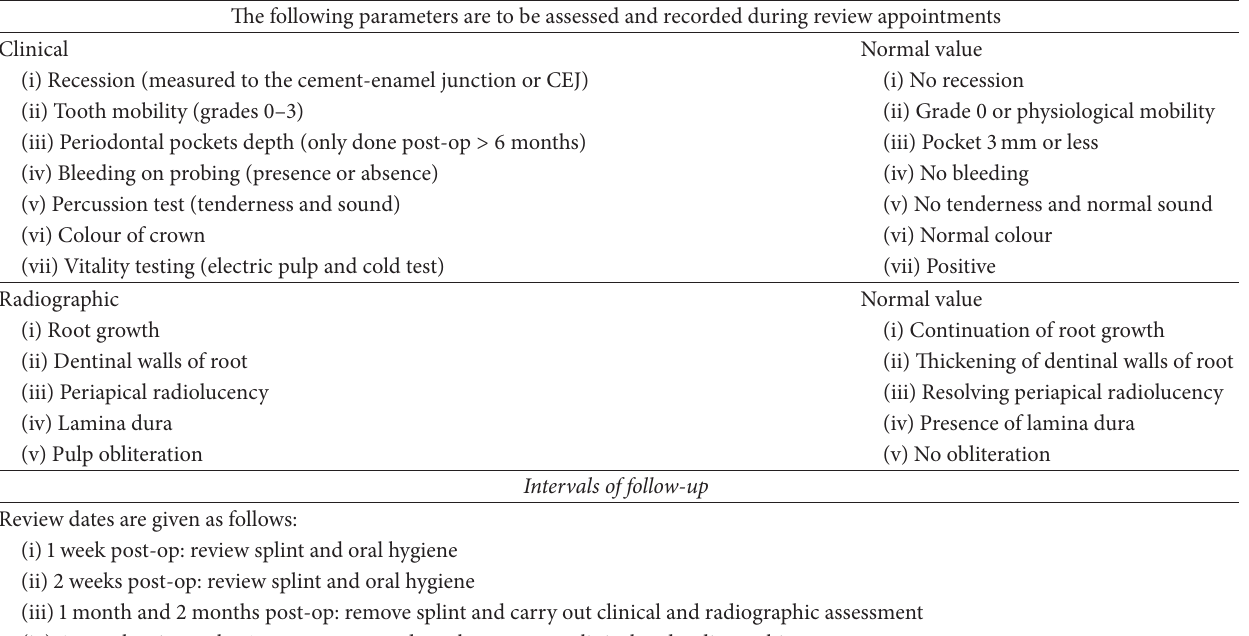
Table 1: Postoperative assessment of autotransplantation of